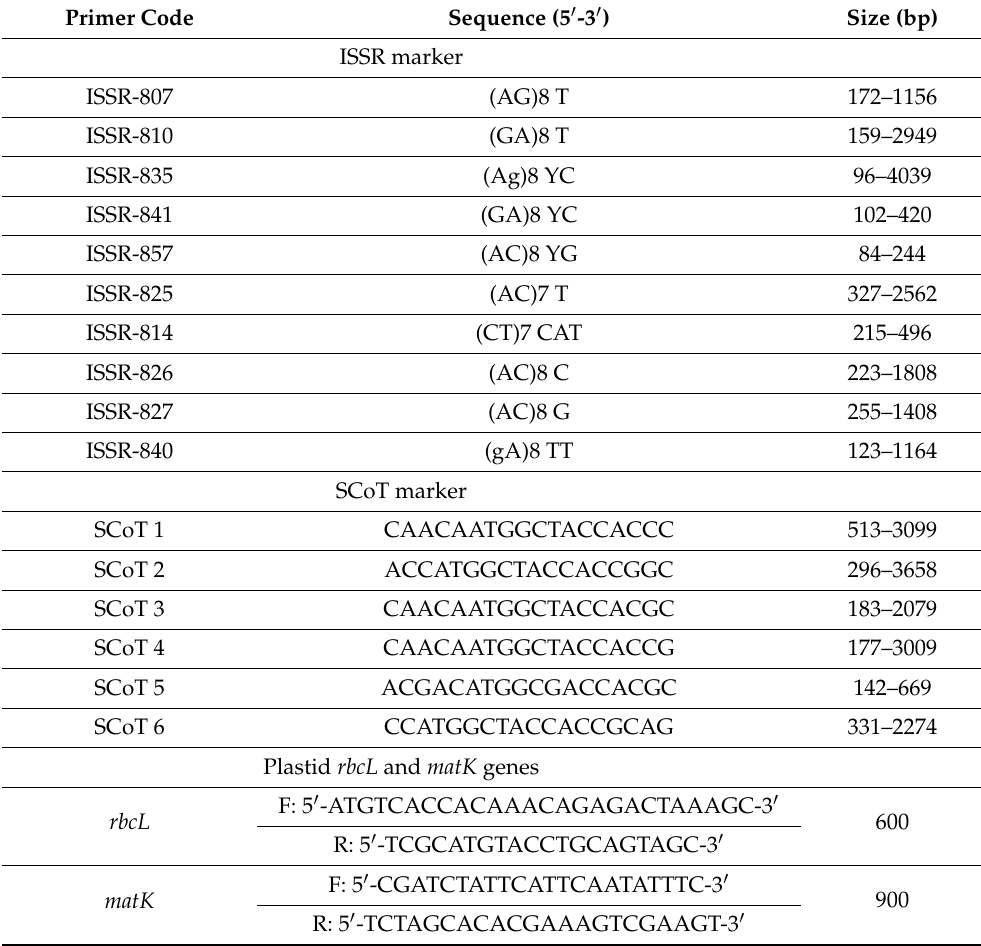
Table 2. List of primers and their sequences for molecular markers (ISSR and SCoT) and plastid rbcL and matK